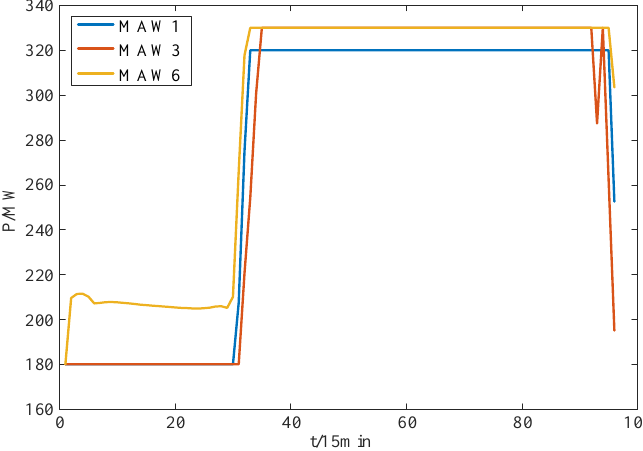
Figure 18. Active power output schedule of coal-fired units.